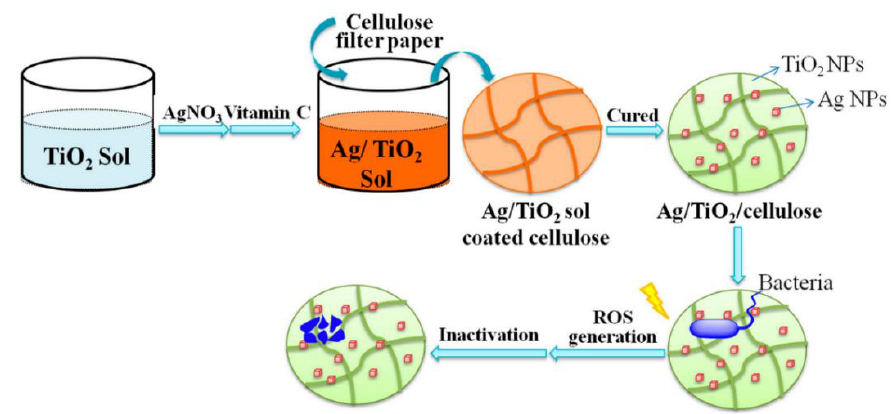
Figure 3. Schematic illustration of preparation of the nanocomposite film of Ag/TiO 2 /cellulose and its antibacterial mechanism. Reproduced with permission from ref. [81]. Copyright © 2018, MDPI.